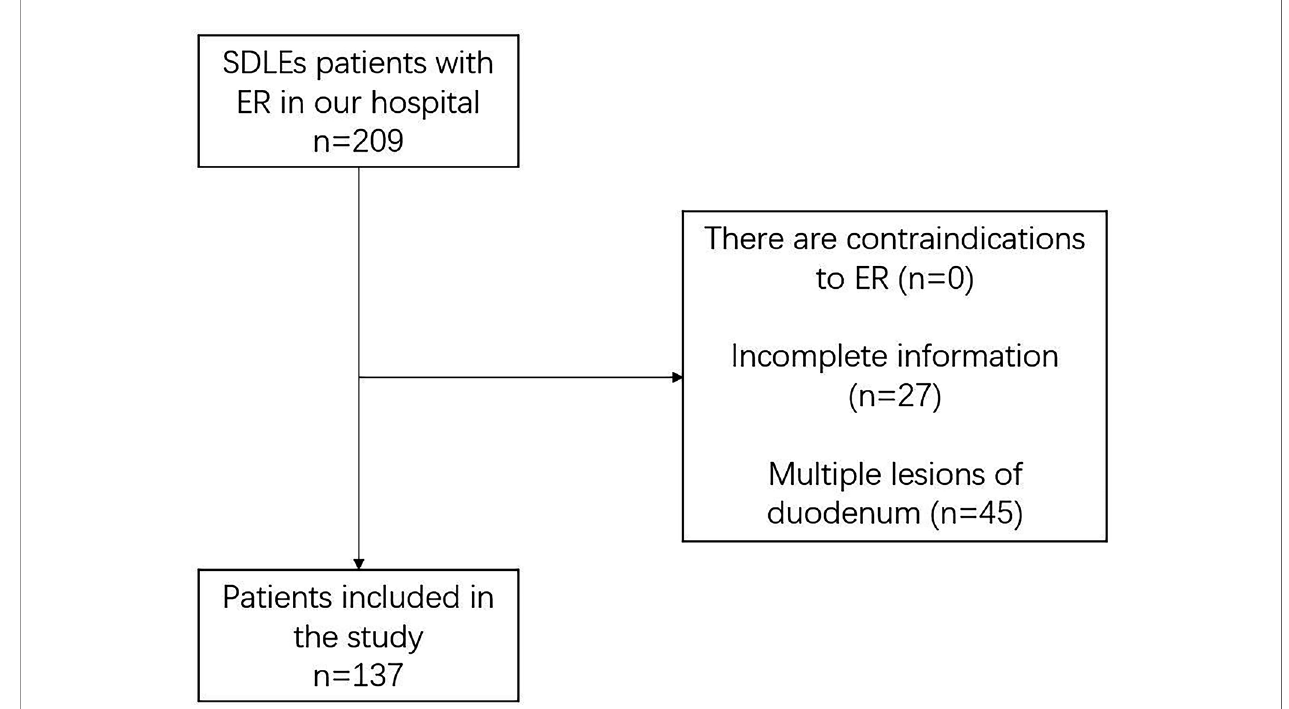
FIGURE 3 | Patient screening process